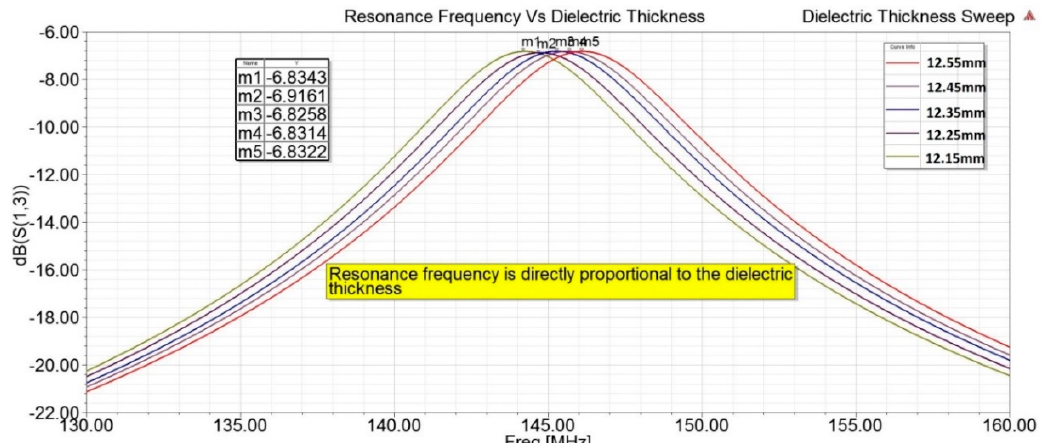
Figure 8. Tuning of the resonance frequency by changing the dielectric thickness of the Macor ceramic. Markers represent the resonance frequency and signal coupling to beam entry port for different pickup positions.